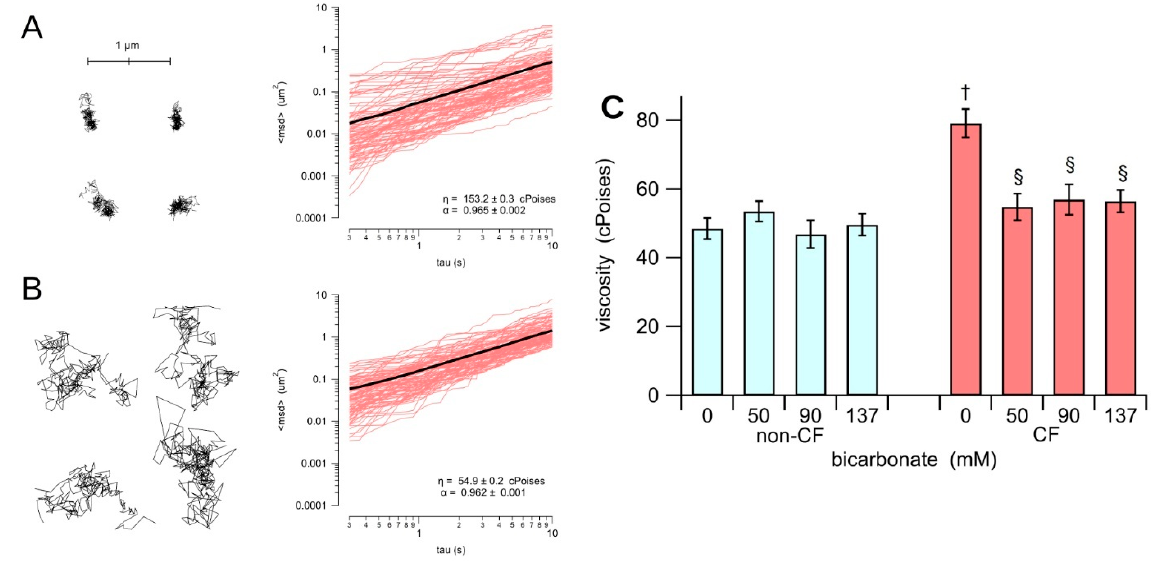
Figure 1. Micro-rheology of the apical fluid recovered from the HBEC-monolayers cultured on Snapwell permeable supports. The trajectory of four nanospheres were recorded in ASL from CF epithelia in a 0 bicarbonate solution ( A ) and from CF epithelia incubated with 90 mM bicarbonate ( B ). The plot of the square displacement against the time interval of 100 nanospheres are shown. The mean square displacement is indicated as a black solid line. The valued of the viscosity ( η ) and the no-linear parameter α are indicated in each plot. The panel ( C ) shows the average of the viscosity of the ASL collected from non-CF (cyan) and CF (red) HBEC-monolayers treated with iso-osmotic solutions with different concentra- tions of bicarbonate. The section sign (§) indicates that data is statistically different ( p < 0.0007) from the CF in 0 bicarbonate solution; the dagger (†) indicates that, in 0 bicarbonate solution, CF is statistically di ff erent ( p < 0.0001) from the non-CF.